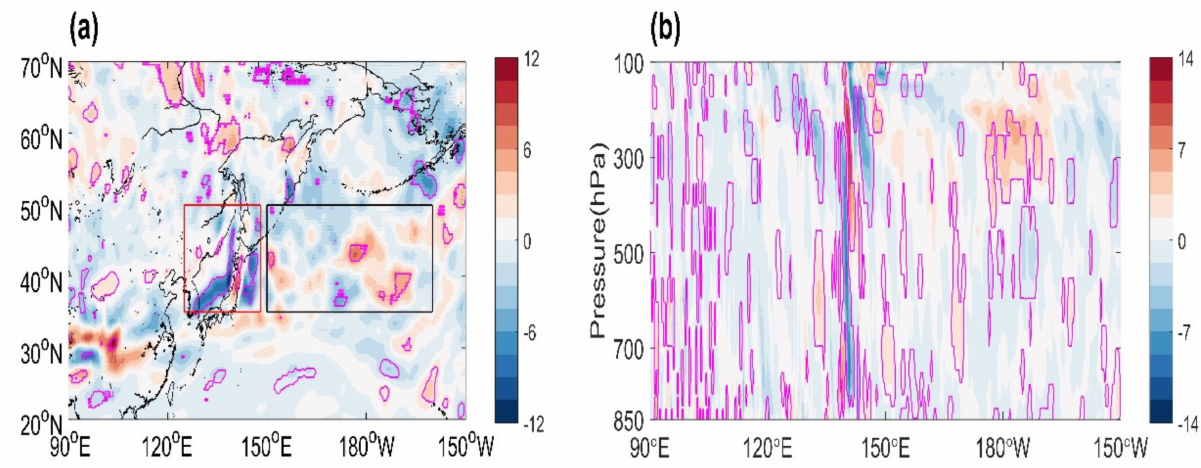
Figure 5. The estimated responses of RWS (shading, unit: 10 − 11 s − 2 ) ( a ) at the 300-hPa level and ( b ) along 35 ◦ N meridional average in DJF onto the KEI 2 months earlier. The red and black rectangular in ( a ) denote the Rossby wave sink and RWS related with the KE fluctuation, respectively. Magenta contours represent where the atmospheric anomalies are significant at the 90% confidence